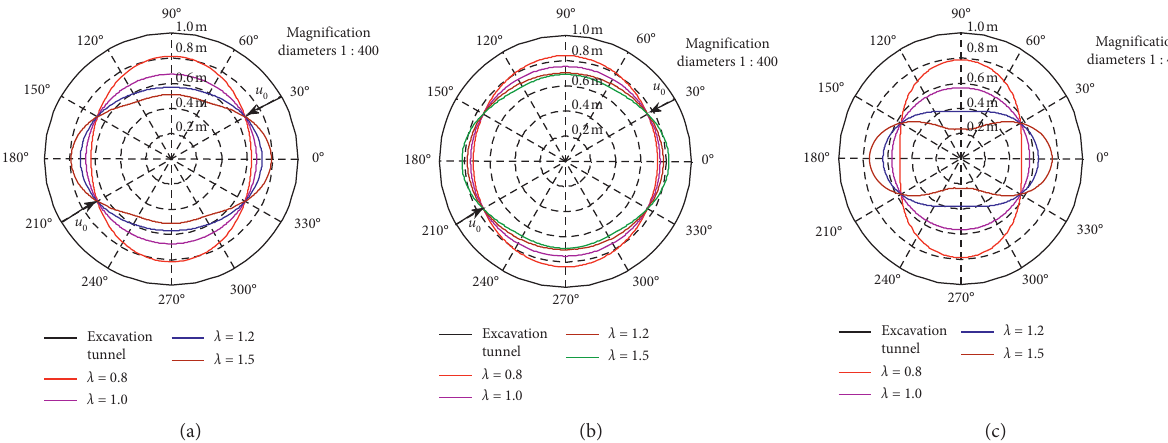
Figure 5: Effect of lateral pressure coefficient on the surface displacement of surrounding rock. Parameter values: v � v � 0 . 2 , α � 0 ,E � E � 5GPa. (a) σ � 1 MPa , β � 1 . 5. (b) σ � 1MPa , β � 1 . 0. (c) σ � 1MPa , β � 2. u is the radial displacement at r r r r r 0 0 0 0 the surface of tunnel. Note. As the displacement at the surface of surrounding rock is small, the result is scaled up by 1: 400 to give a more intuitive illustration.